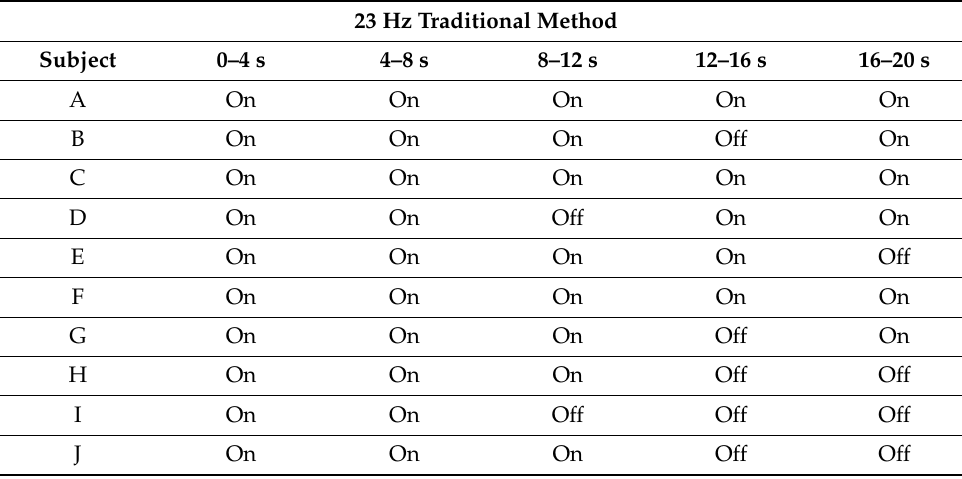
Table 4. The traditional method has five signals in the 23 Hz brainwave signal.